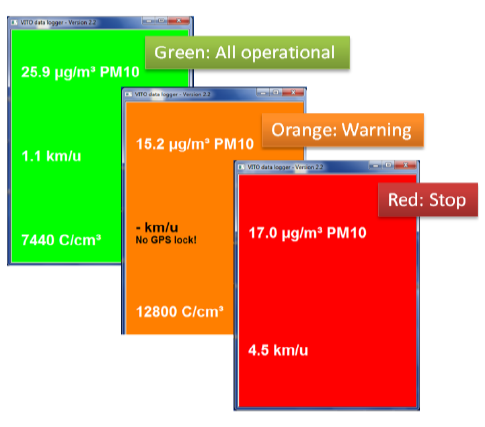
Figure 3. Traffic light GUI.